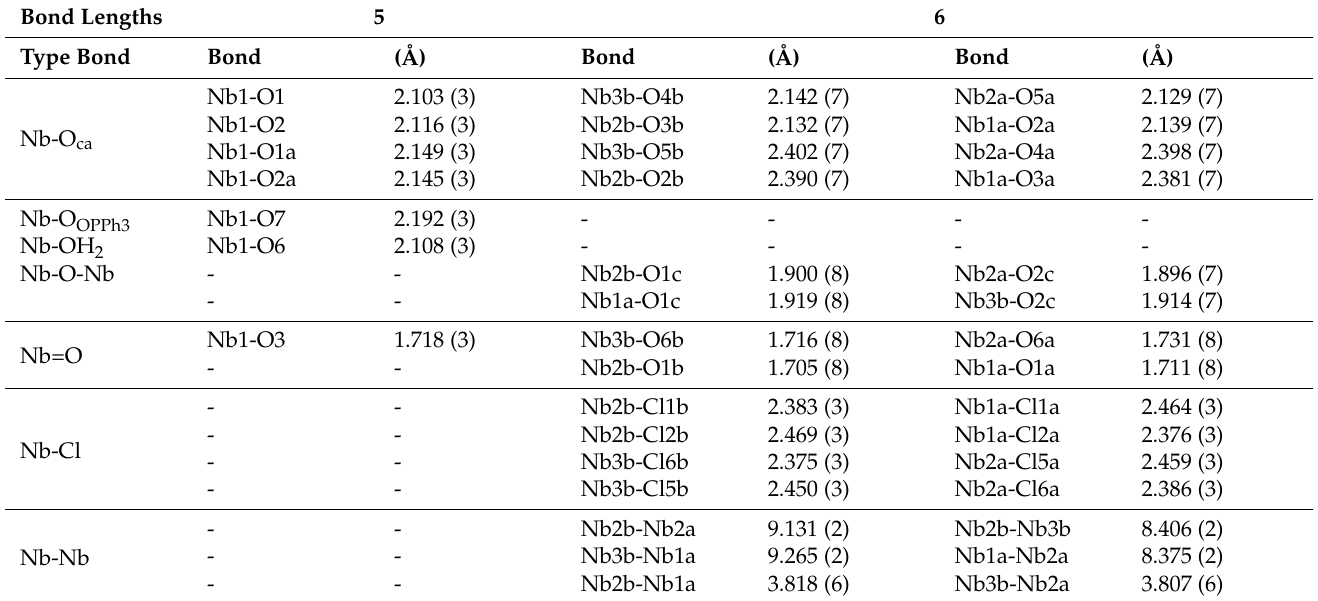
Table 3. Selected coordination bond lengths in (Et 4 N) cis -[NbO(ca) 2 (H 2 O)OPPh 3 ] · 3H 2 O · THF ( 5 ) and